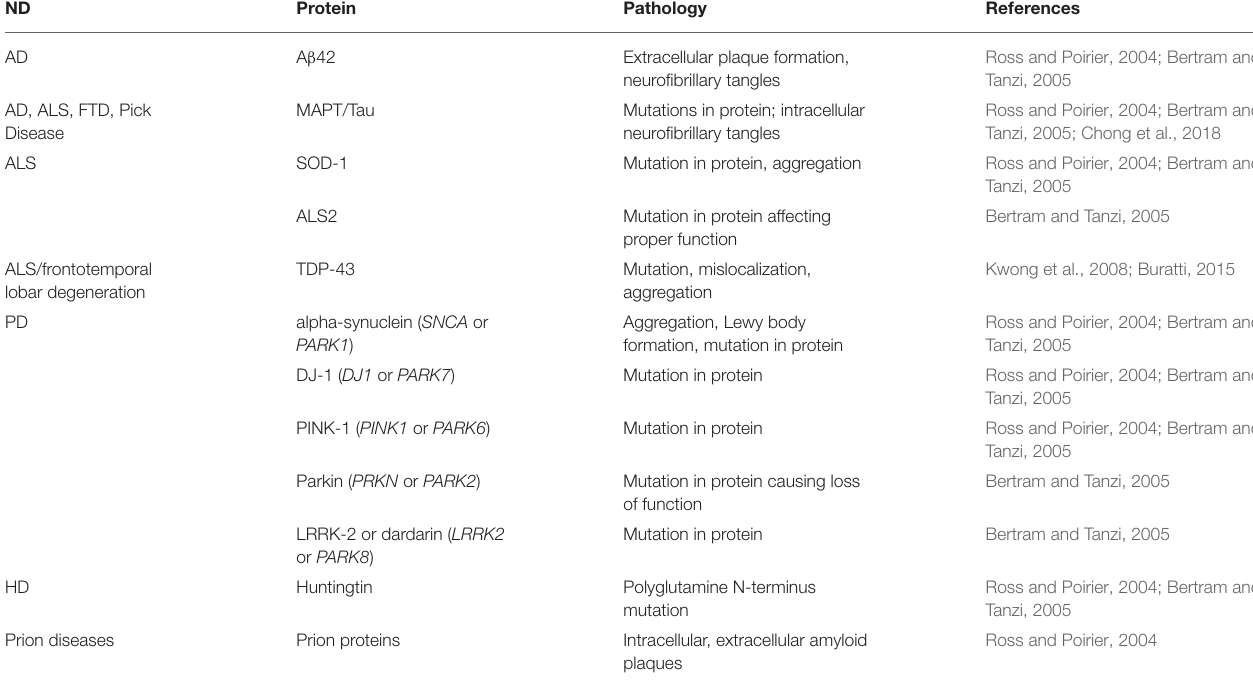
TABLE 1 | Neurodegenerative Diseases (NDs) and associated pathogenic